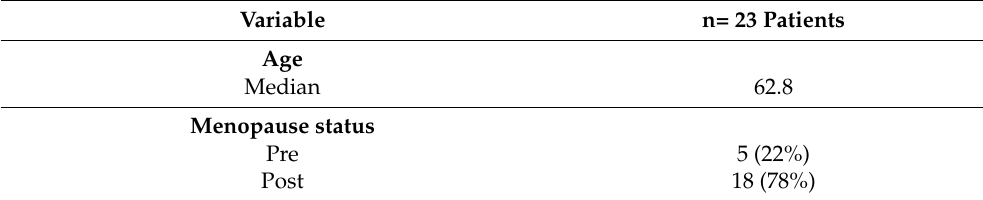
Table 1. Patients’